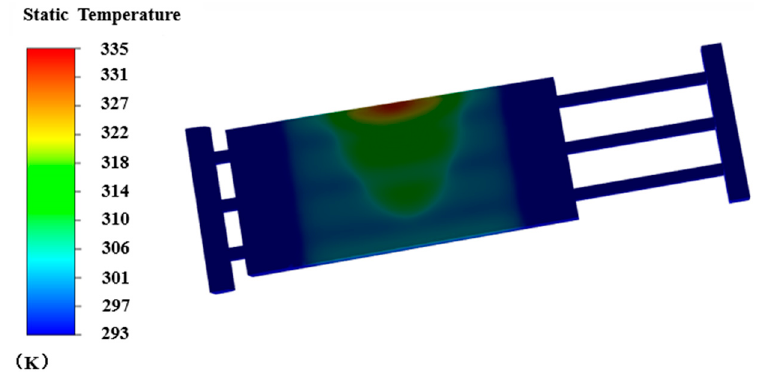
Figure 11. The temperature field of entrance collimator (at the 100th second).